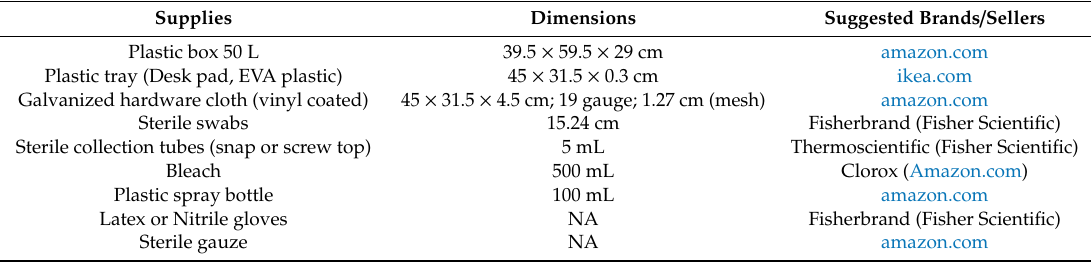
Table 1. All Materials used for the fecal collecting method with the examples of brands /